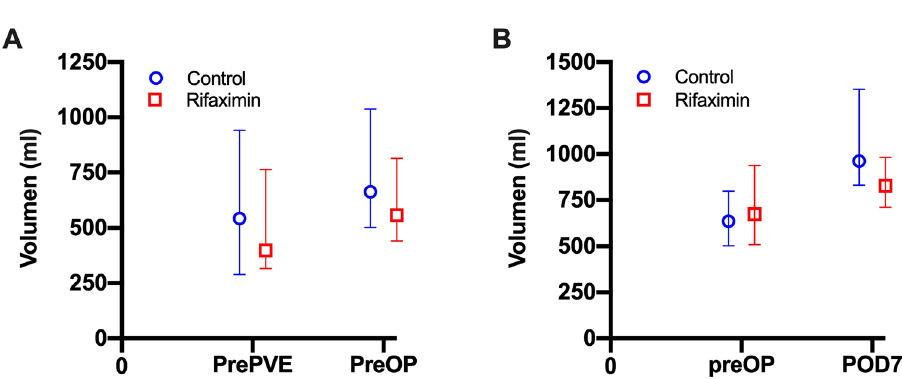
Figure 4. Course of future liver remnant liver volume with respect to trial group. FRLV was assessed on different time points during the trial period is presented as median and interquartile range ( A ) Volumetric growth after PVE. FRLV subsequently increased after PVE in both groups with no statistical in any time point (prePVE: p = 0.234; preOP: p = 0.279; only patients undergoing PVE were analyzed). ( B ) Volumetric growth after liver resection. FRLV increased after surgery in both groups with no statistical in any time point (postOP: p = 0.987; POD 7: p = 0.140). FLRV, future liver remnant volume; POD, postoperative day; prePVE, prior to PVE; preOP, prior to